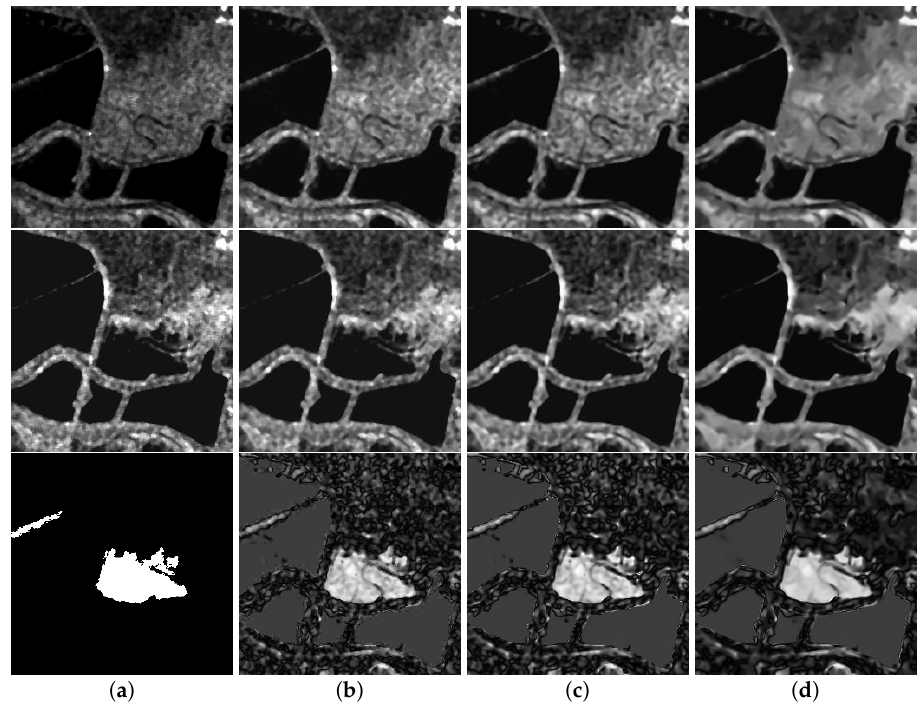
Figure 2. San Francisco dataset. ( a ) Raw images from August 2003 and May 2004 and reference map. ( b – d ) Filter images by MMSE, SAR-BM3D, PPB, and the corresponding DIs.